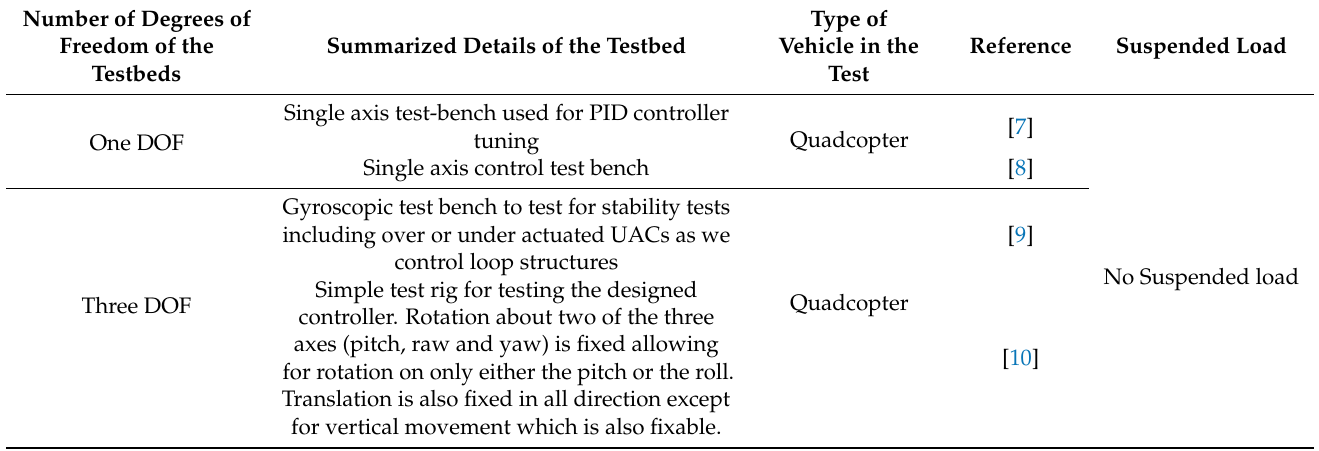
Table 1. Information on testbeds for multirotor flying vehicles reported in the